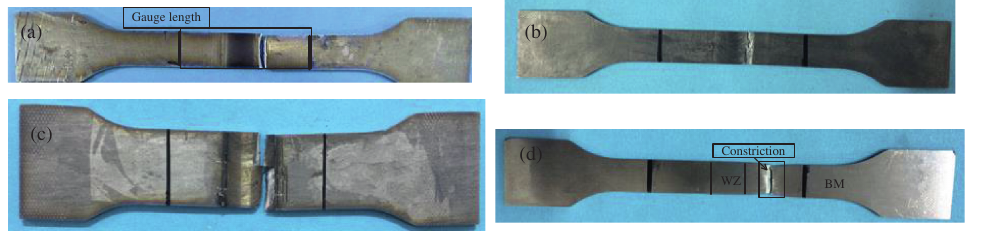
Figure 6: Tensile fracture specimens with surface indentation: (a) 1.8mm (b) 2mm and (c) 2.5mm; without surface indentation: (d)